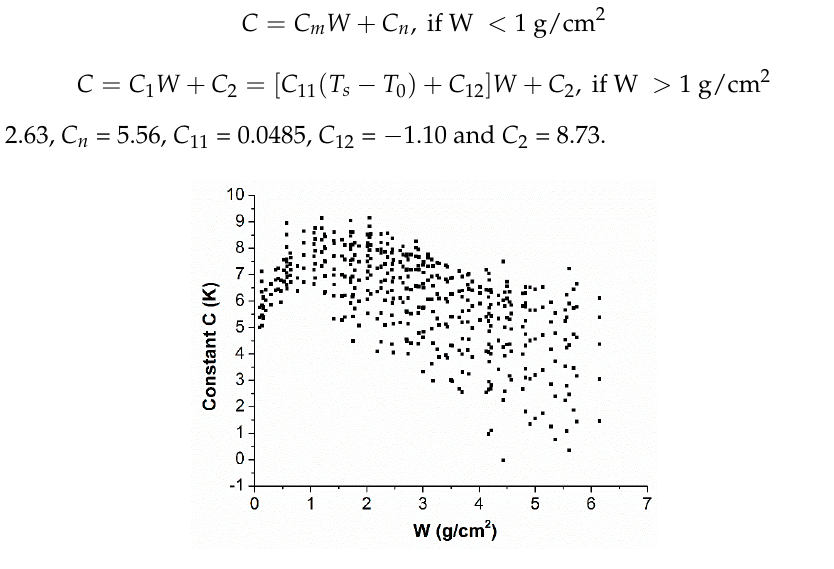
Figure 7. Constant C in Equation (1) versus the water vapour content (W), considering a channel mean emissivity of 0.90 and an emissivity difference of − 0.02. Coefficients A and B in Equation (1) were set to 0.2809 and 1.447, respectively, obtained for a black body.